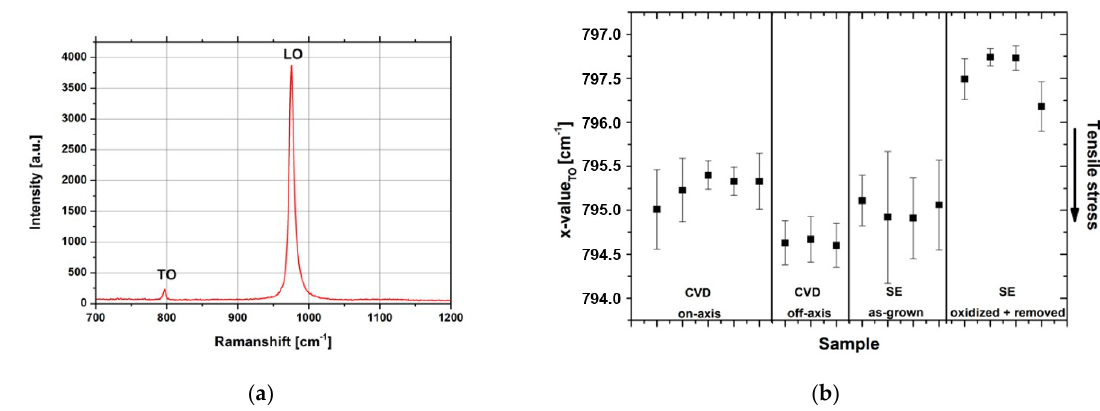
Figure 4. ( a ) Typical Raman spectrum of SE-grown material in a protrusion- and defect-free surface area. ( b ) Comparison of the x-value for the transversal optical (TO) mode of 3C-SiC epitaxial layers grown by chemical vapor deposition (CVD) (on and 4° off-axis), homoepitaxial as-grown material using the SE setup, and after oxidation and removal from the carrier. The obtained values feature a trend of stress reduction for the final material. Table 1. Lattice parameters calculated from XRD 2 θ - ω scans on SE-grown material and 3C-SiC-on-Si